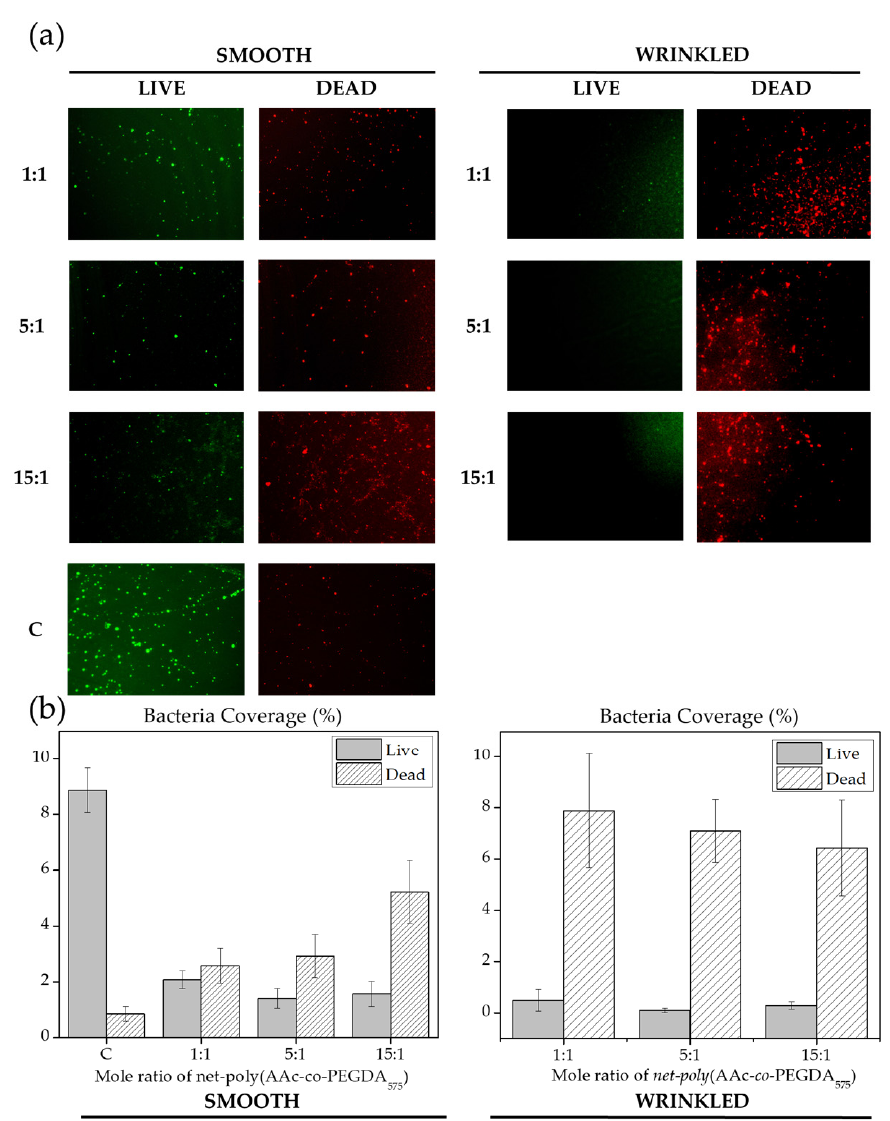
Figure 10. LIVE/DEAD assay for smooth and wrinkled AAc films incubated with Staphylococcus aureus bacteria strain: ( a ) live (green) and dead (red) bacteria over wrinkled, smooth, and control (C) films after 48 h of incubation and ( b ) surface area coverage (%) of bacteria culture after ImageJ analysis.